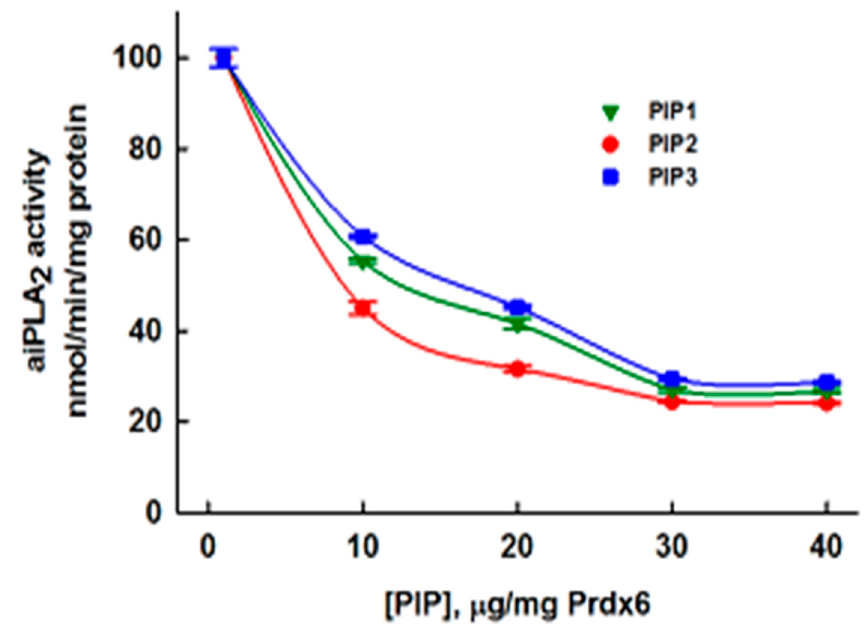
Figure 2. Effect of the concentration of PIP peptides on the aiPLA 2 activity of recombinant human Prdx6. Results are mean + SEM for n = 3.